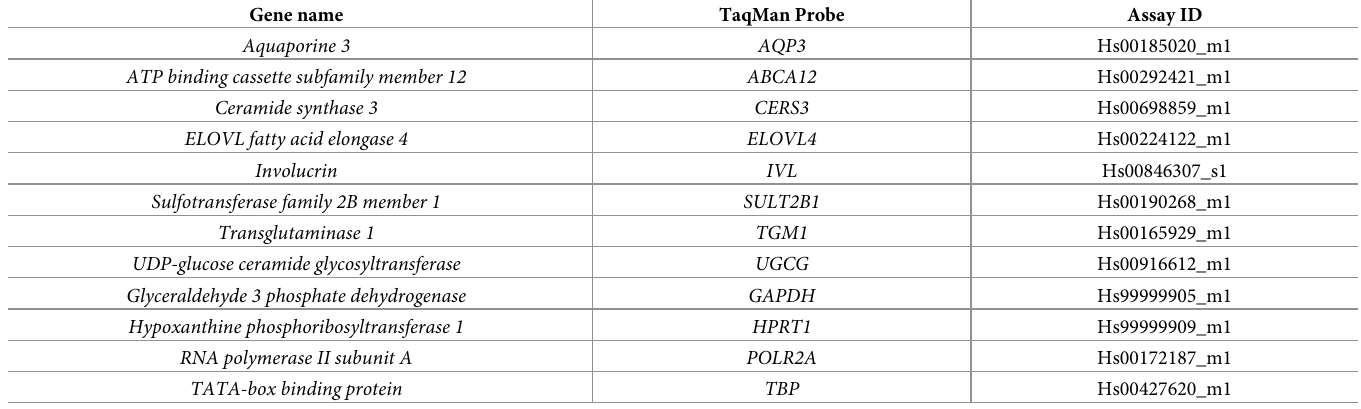
Table 2. Primers used for TaqMan real-time